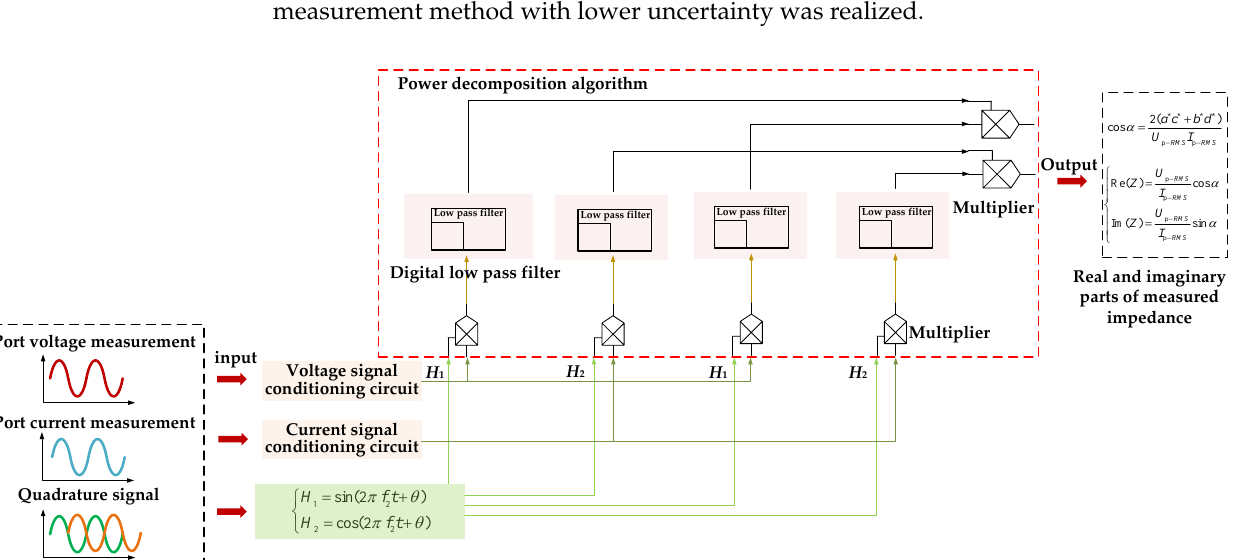
Figure 15. Improved impedance region proposed by the Tiangong University.